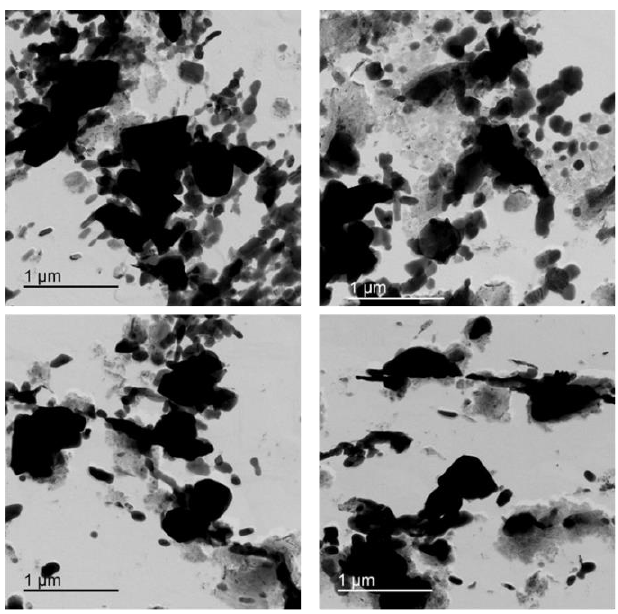
Figure 22. Failed crept cross-weld specimen 92-HAZ-6-5 650 °C 78 MPa 4616 h (sample G). TEM images on a carbon extraction replica at 50,000X.